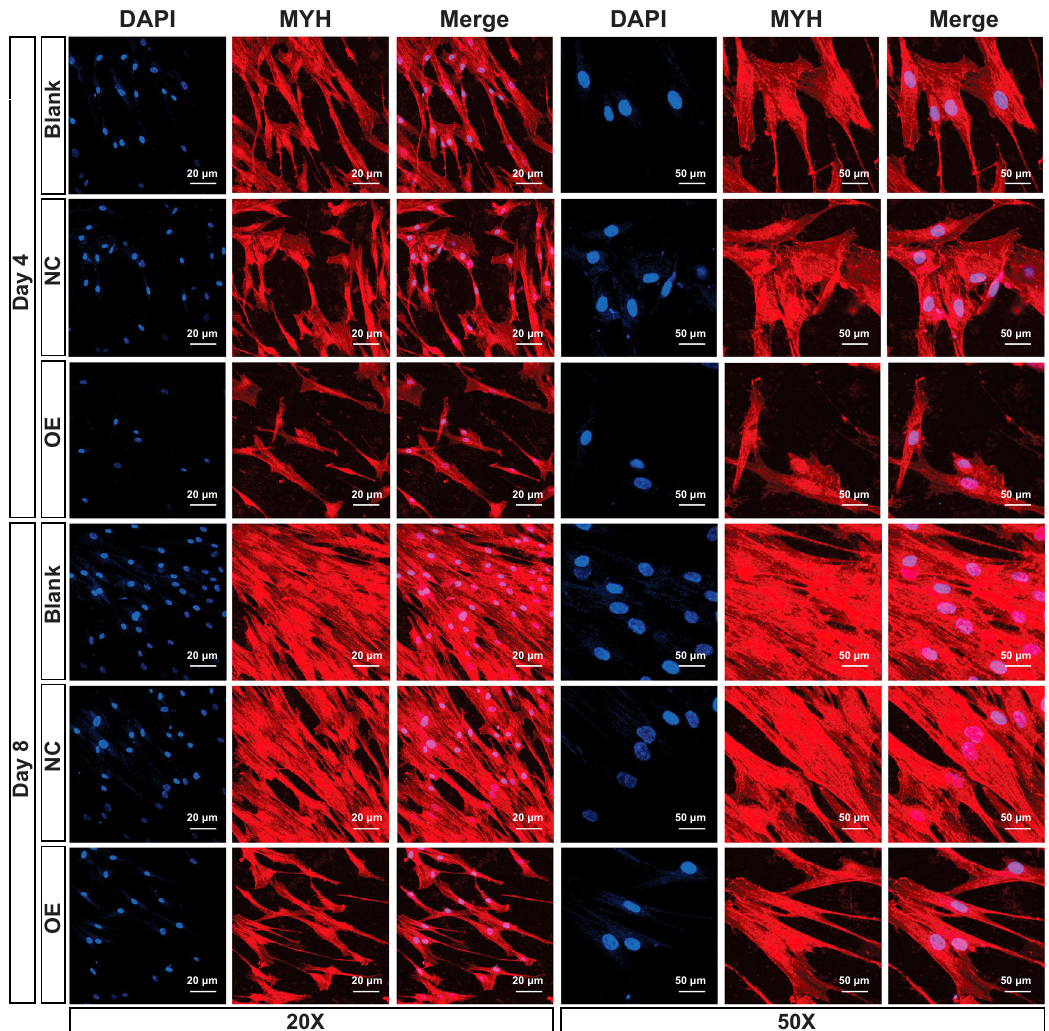
Fig. 6 Secreted protein of TP12446 inhibits differentiation of C2C12 cells. Cells were fi xed after 4 or 8 days, stained with anti-Myosin Heavy Chain (MHC) antibody and counterstained with DAPI. The three transgenic mouse cell lines were: (1) normal cell (Blank), (2) an empty lentiviral vector PSE- CMV-NC (NC), (3) a lentiviral vector PSE-CMV-TP12446 with overexpression of TP12466 (OE). These images are representative of three biologically independent